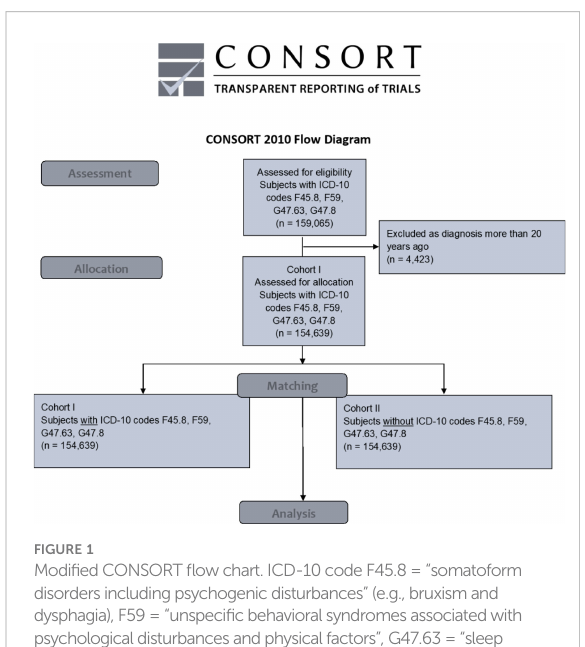
FIGURE 1 Modi fi edCONSORT fl owchart.ICD-10codeF45.8= “ somatoform disordersincludingpsychogenicdisturbances ” (e.g.,bruxismand dysphagia),F59= “ unspeci fi cbehavioralsyndromesassociatedwith psychologicaldisturbancesandphysicalfactors ” ,G47.63= “ sleep relatedbruxism ” ,G47.8= “ othersleepdisorders ” ICD-10=International Classi fi